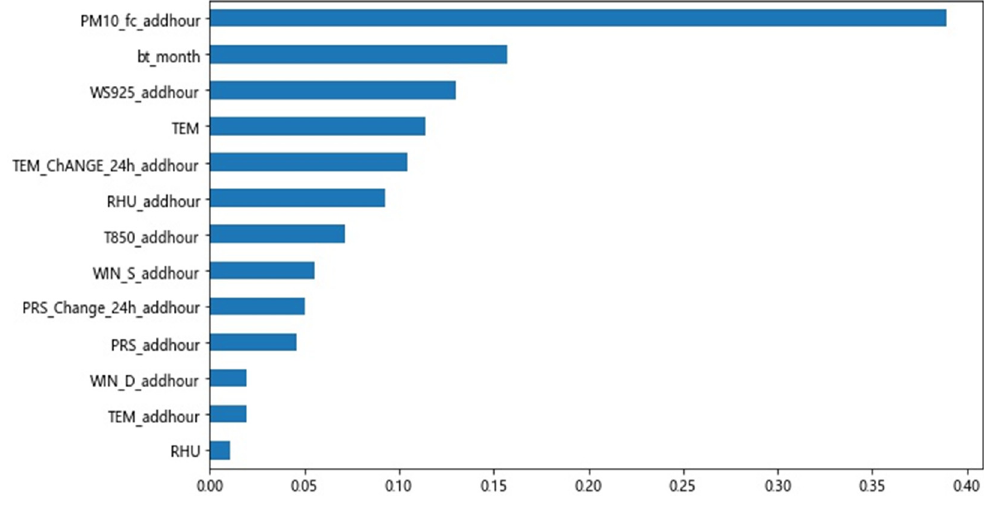
Figure 4. PM 10 Characteristic factor.